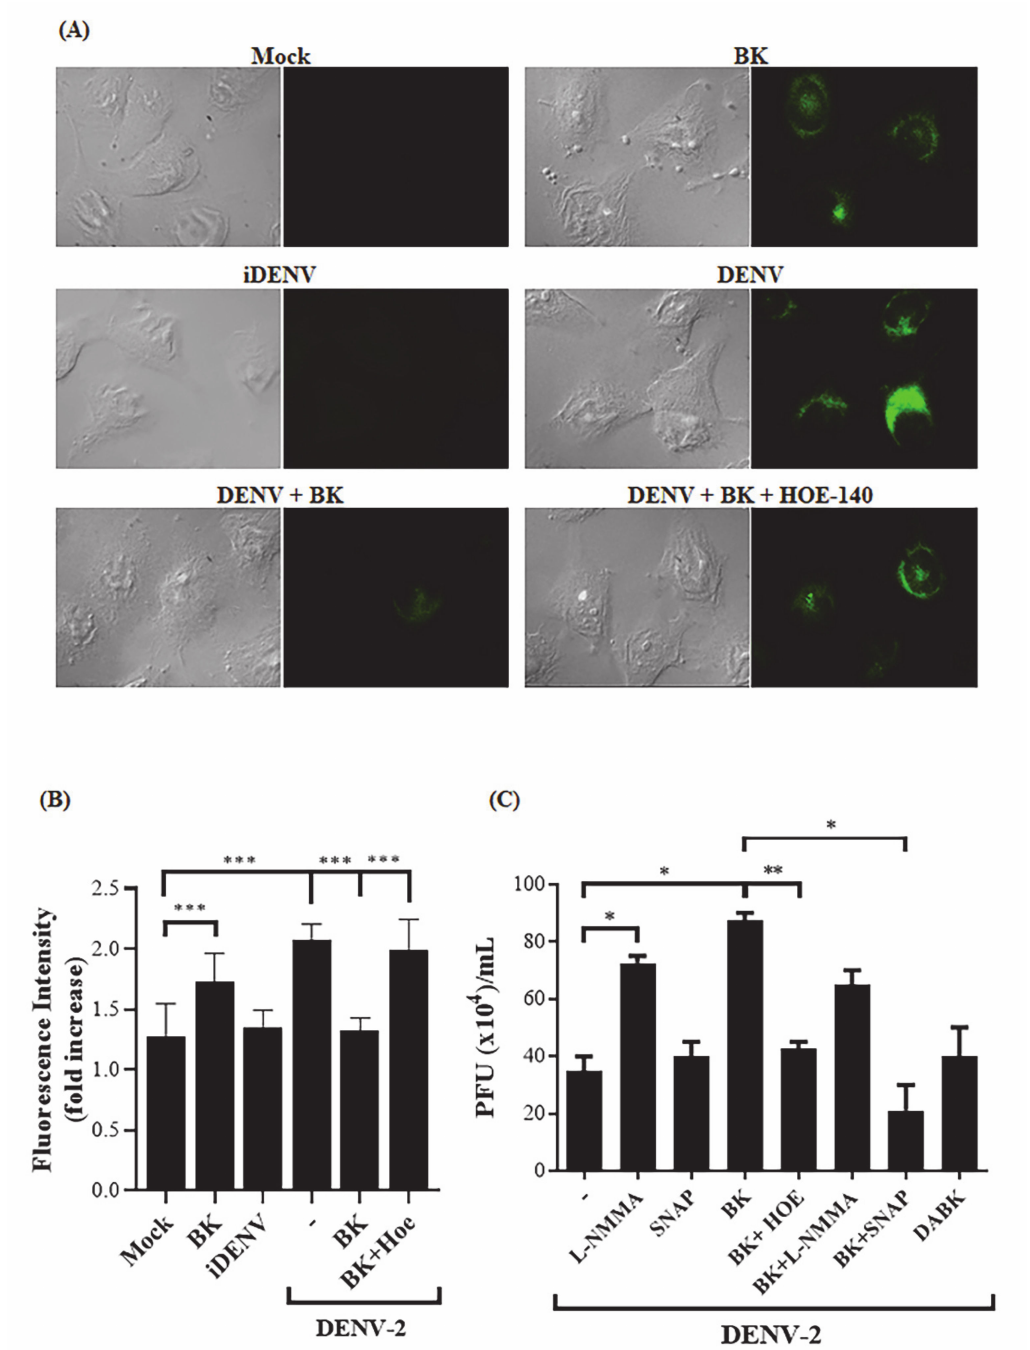
Figure 3. Addition of BK to DENV-infected HBMECs reduced nitric oxide production in a B2R-dependent way. ( A , B ) HB- MECs were mock-treated or cultured with infectious DENV-2 or UV-inactivated DENV (iDENV). In some cultures, the cells were further incubated with BK for 30 min, in the presence or absence of HOE-140. After 24 h, the cells were incubated with DAF probe. NO production was analyzed by fluorescence microscopy ( A ) and the average of fluorescence intensity was measured by ImageJ software (v. 2.1.0/1.53c) ( B ). ( C ) HBMECs were infected with DENV and 24 h later the cells were treated with BK or L-NMMA, in the presence or absence of HOE-140 or SNAP. At 72 h.p.i., the supernatants were harvested, and viral replication was analyzed by plaque assay. The data are representative of four independent experiments and error bars indicates SD values between replicates in all experiments. * represents p ≤ 0.05; ** represents p ≤ 0.01; *** represents p ≤